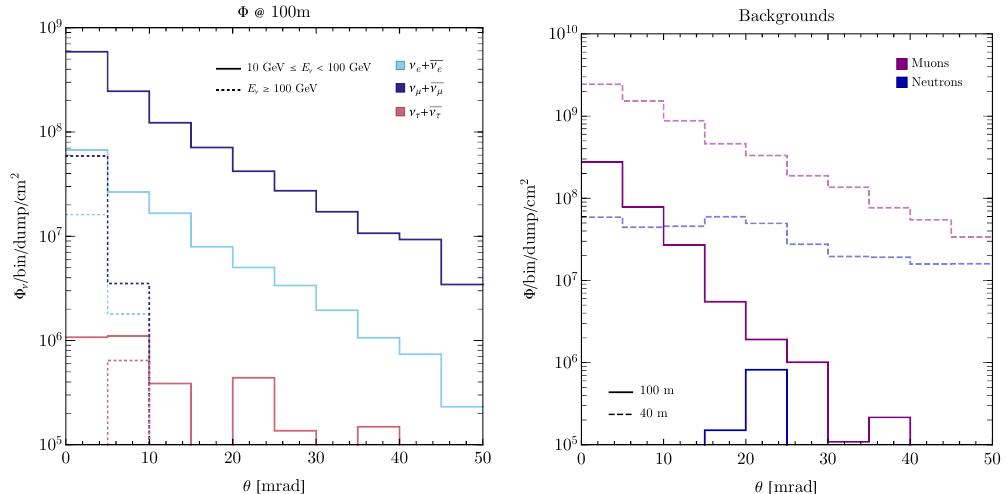
Figure 11. Left: high-energy neutrino flux ( E ν > 10 GeV ) as function of the angle relative to the beam direction for detectors at a position of 100 m from the interaction point. Right: forward muon (purple) and neutron (dark blue) flux as function of the angle relative to the beam direction. Full (dashed) lines indicate the flux at 100 (40) m from the interaction point.